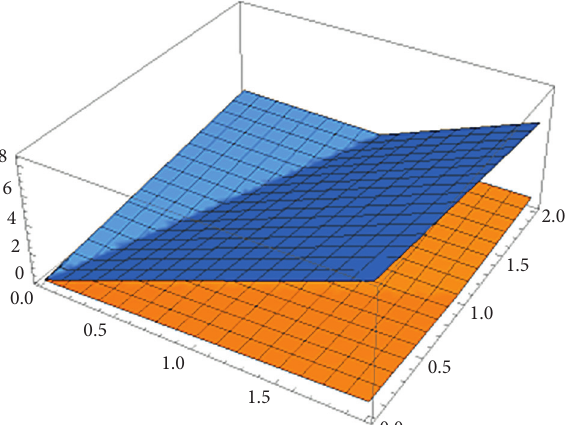
Figure 7: Dominance of the right-hand side of equation (36) is visually checked for τ > 2, υ ∈ [ 0 , 2 ] .